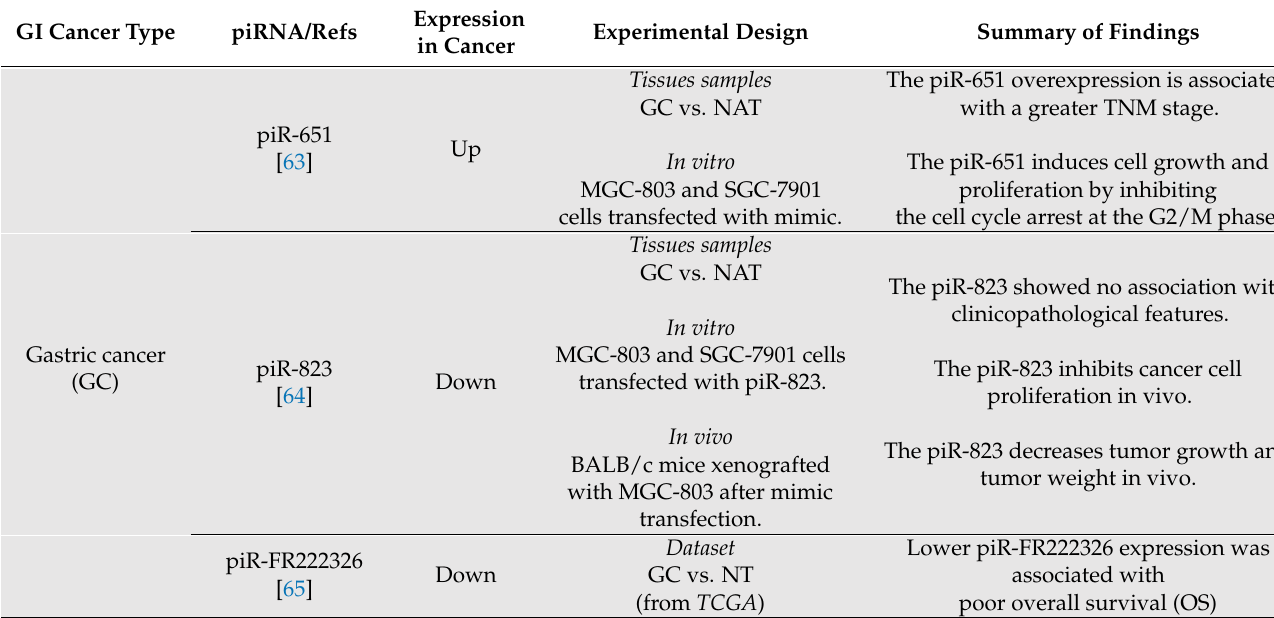
Table 1. The role of piRNAs in GI